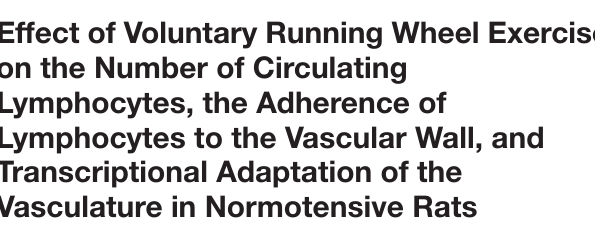
analyzed in blood samples from normotensive rats shortly before the end of the trial. Ten months running wheel exercise had no effect on these counts with neutrophils being an exception. The amount of circulating neutrophils was ∼ 40% lower in rats with running wheel activity compared to their sedentary counterparts ( Figure 1 ). Although the amount of circulating monocytes did not vary between both groups the number of cells that migrate into the vessel wall as well as the number of cells that adhere to the vascular endothelium may differ. Therefore, the number of CD206 + cells was quantified in histological slices. However, there was again no difference at all ( Figure 2